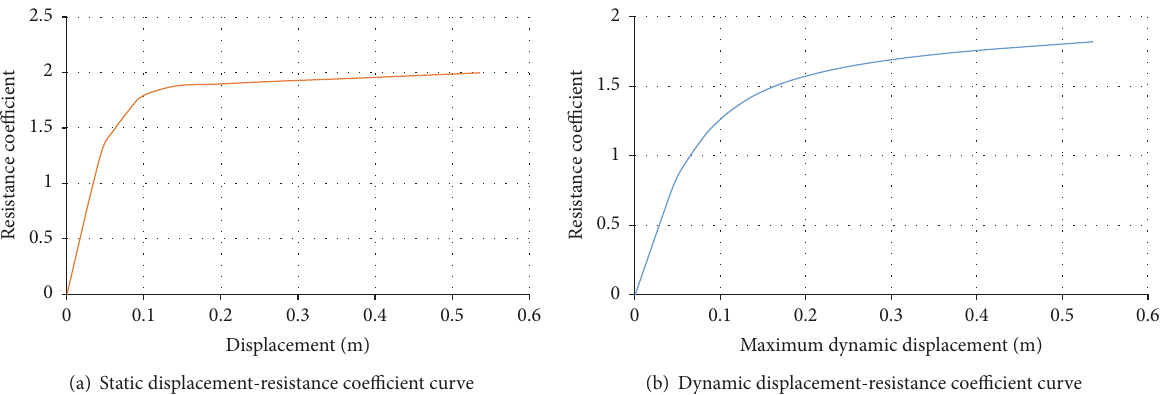
Figure 16: Vertical displacement-resistance coefficient curve of the hybrid structure after the failure of the bottom corner column.